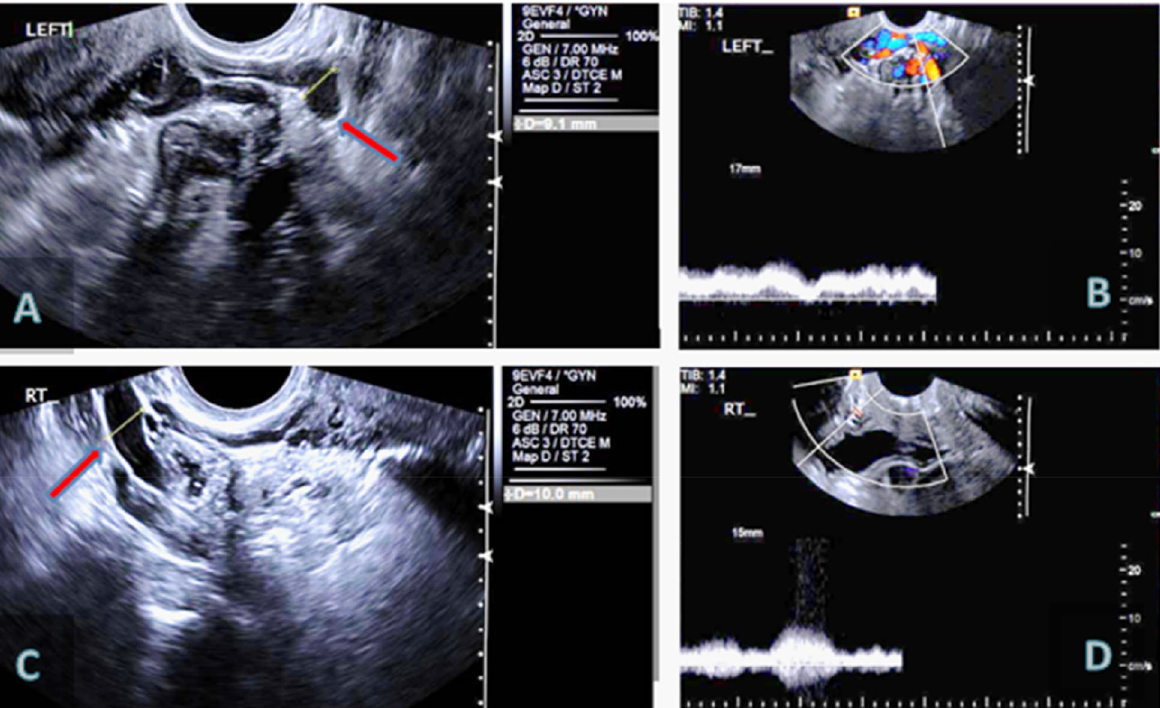
Fig. 3 Trans-vaginal and Doppler ultrasound studies in a multiparous woman presenting with bilateral lower limb varicosities and pelvic pain. Pelvic venous congestion with left ovarian vein diameter of 9.1mm ( A ), and right ovarian vein diameter of 10mm ( C ) (red arrows), both diameters increased with Valsalva manoeuvre. Left ( B ) and right ( D ) ovarian vein Doppler studies Average flow